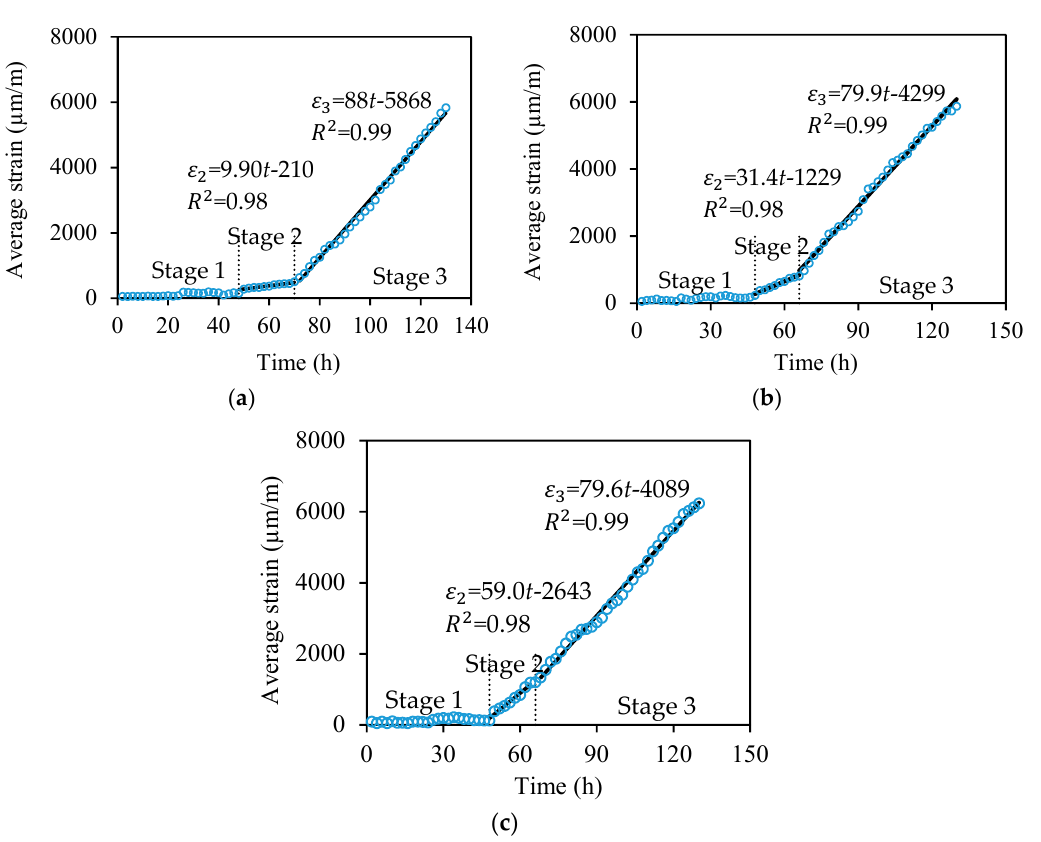
10 of 15 Figure 8. Detailed strain distributions along the distributed fiber optic sensor for different installation methods: ( a ) S0; ( b ) S2; ( c ) S5; ( d ) S10; and ( e ) L4. Figure 8a shows the strain results from S0. There is no obvious strain change within the first 18 h. Then, the strain increases with time until 56 h. The strain change within the length 7.2 m to 9.0 m is larger than the strain change in the other parts of the fiber, indicating that corrosion of the bar length that corresponds to the fiber length from 7.2 m to 9.0 m is more severe. After 56 h, the distributed sensor failed to measure, because of significant signal loss caused by the corrosion induced macrobend of the optical fiber. The macrobend loss is dependent on the bend radius and number of circles. Thus, S0 is more susceptible to macrobend loss compared with the other specimens. Figure 8b shows the strain distributions from S2. The fiber length from 3.0 m to 5.0 m is subjected to strain changes that increase over time until 118 h. The distributed sensor continued to be functional and provided reasonable measurement after 130 h. Once again, non-uniform strain distributions are observed at each time instant. Similarly, Figure 8c,d show the strain distributions from S5 and S10, respectively. The distributed sensors in S5 and S10 continued to be functional after 130 h. Figure 8e shows the strain results from L4. The fiber length from 3.06 m to 3.12 m was in contact with the steel bar. There was negligible strain change over 130 h, revealing that the distributed sensor in L4 failed to detect corrosion of the bar. To investigate the strain increasing rate in different specimens, the expansion strain measured from the distributed sensor is averaged over the fiber length in contact with the steel bar at each time instant. Figure 9a–c plot the averaged strains of S2, S5, and S10, respectively. Each curve can be divided into three stages. In Stage 1, the corrosion products diffuse and gradually filled the surrounding concrete pores [7,34]. This is corroborated by the very small strain change (less than 150 µ ε ) measured from the distributed sensors. Stage 1 is terminated when the majority of concrete pores at the steel–concrete interface is filled up and the corrosion products starts to increase the tensile strains. In Stage 2, the corrosion products continue to expand and tend to increase the tensile stresses in the concrete matrix. Stage 2 ends when concrete cracks. In Stage 3, ingress of water and oxygen is